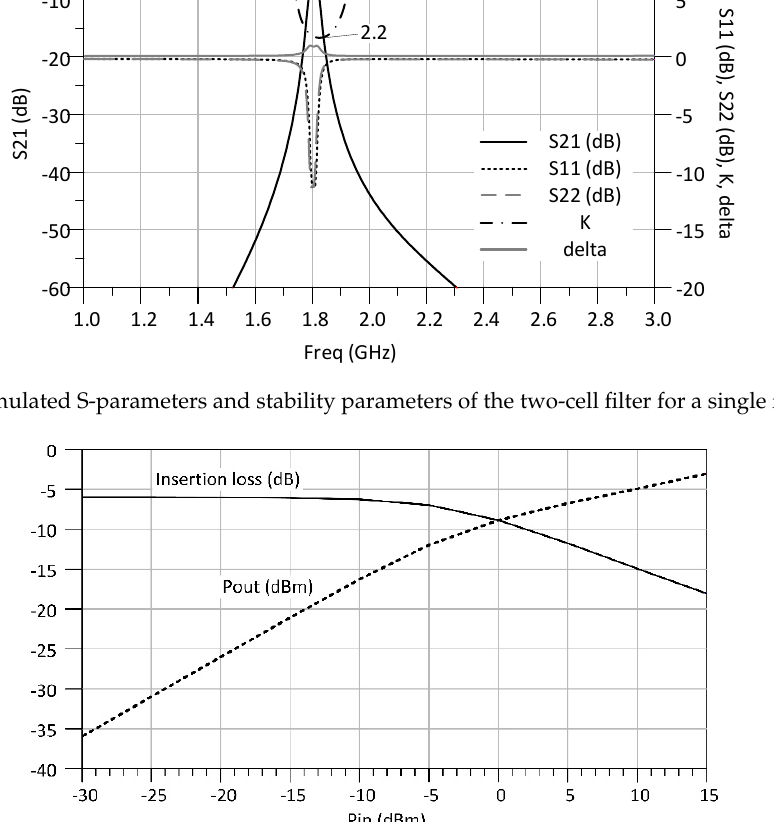
Figure 8. Simulated compression of the filter tuned at 1800 MHz.